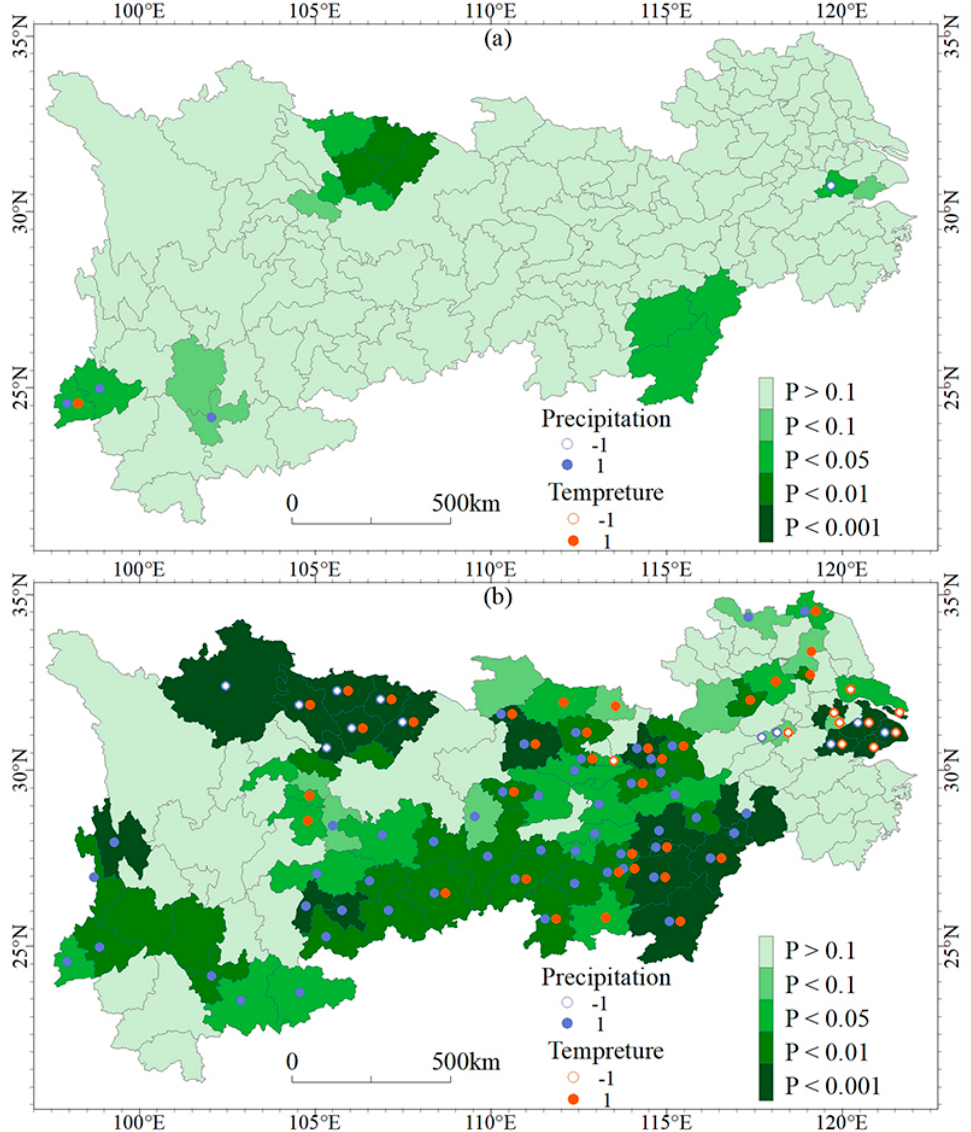
Figure 5. Confidence levels of the growing season NDVI prediction model with temperature and precipitation as predictors calibrated with the original annual data ( a ) and with the five-year smoothed data ( b ) from 1982 to 2003 (the circles and dots denote negative and positive correlations, respectively, with p < 0.1; red denotes the correlation between NDVI and temperature, and blue denotes precipitation).